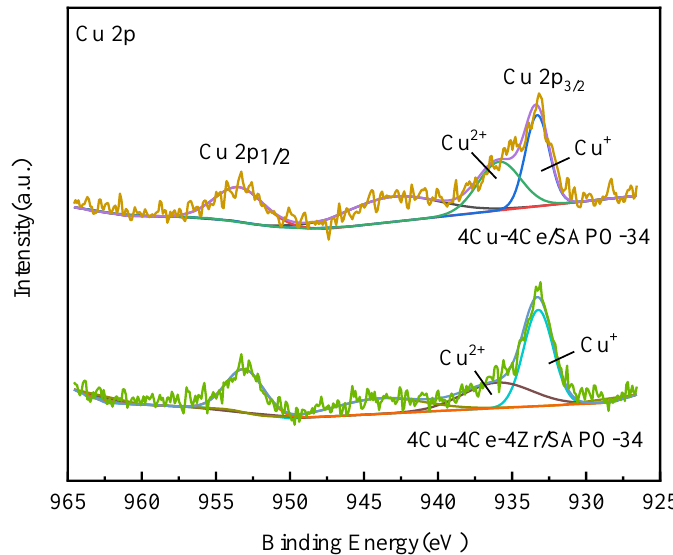
Figure 10. Cu 2p XPS spectra of 4Cu-4Ce/SAPO-34 and 4Cu-4Ce-4Zr/SAPO-34.